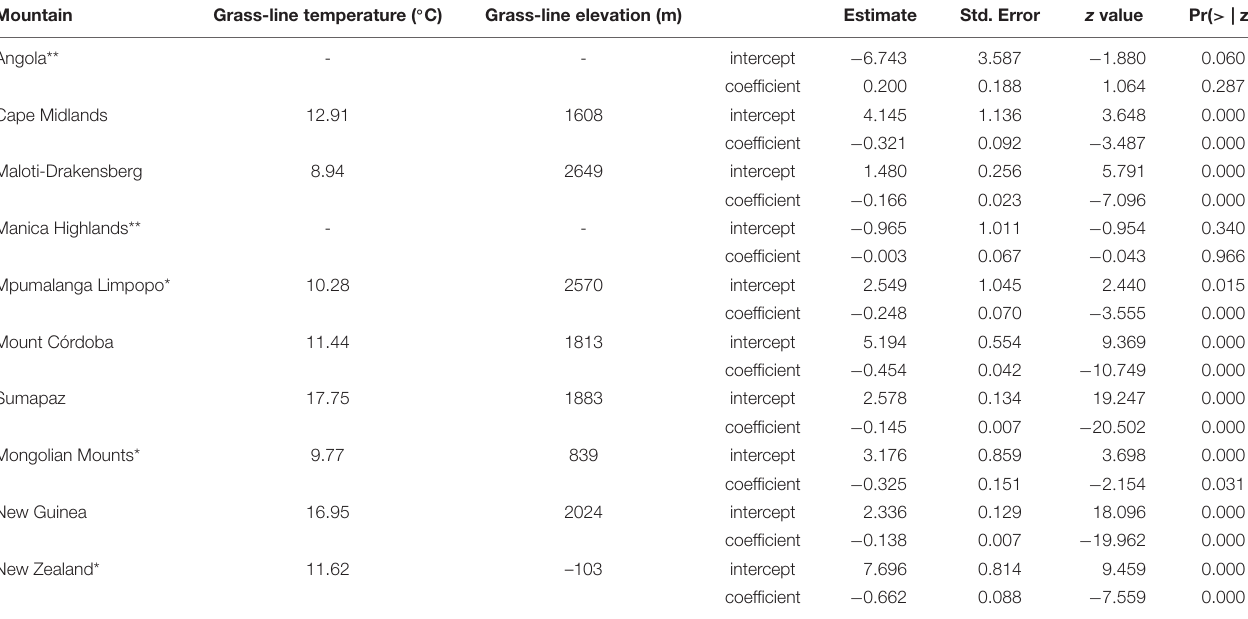
TABLE 2 | Individual mountains grass-line elevation and model coefficients for each generalized linear model fitted for C 3 proportion and elevation data. Mountain Grass-line temperature ( ◦ C) Grass-line elevation (m) Estimate Std.